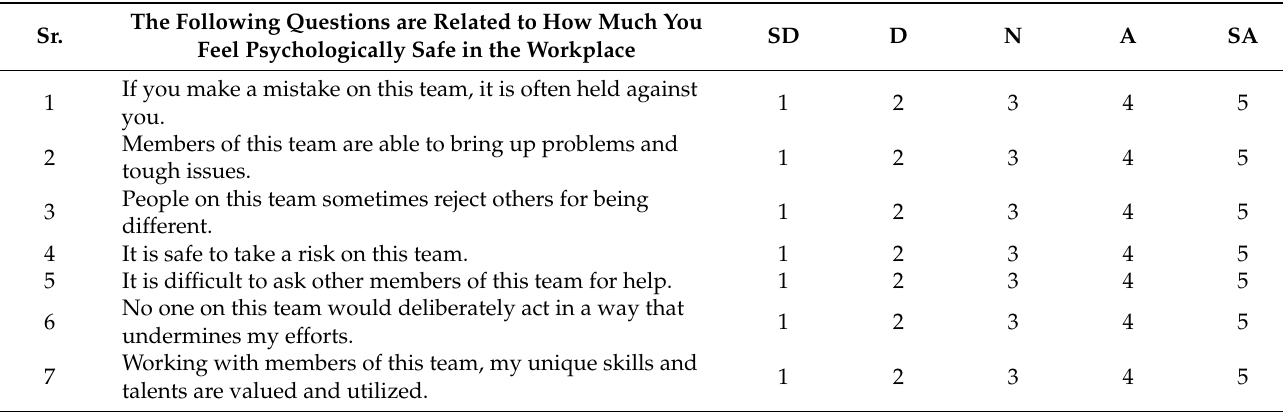
Table A4. Psychological safety